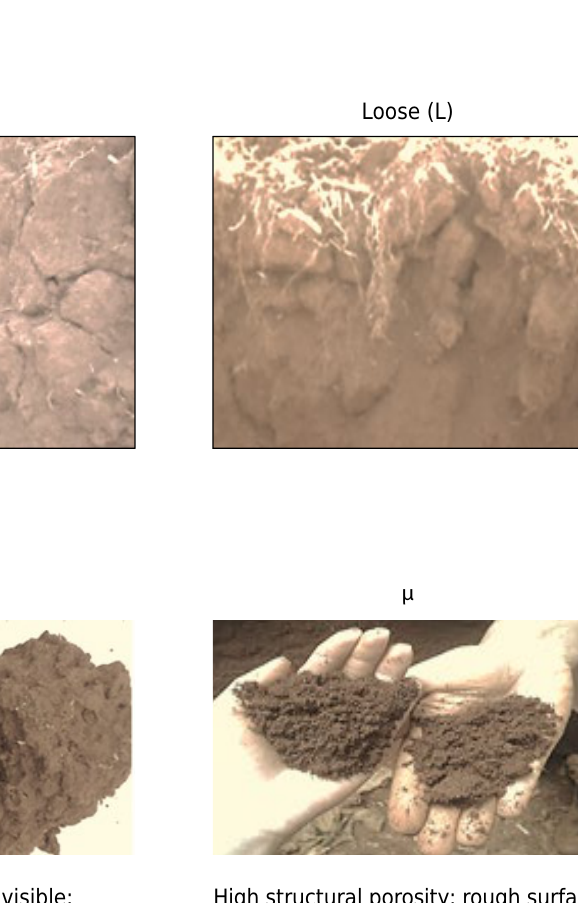
Figure 1. Soil profile methodology used for study of the structural evolution of soils in the different management systems. Adapted from Gautronneau and Manichon (1987) by Tavares Filho et al. (1999).